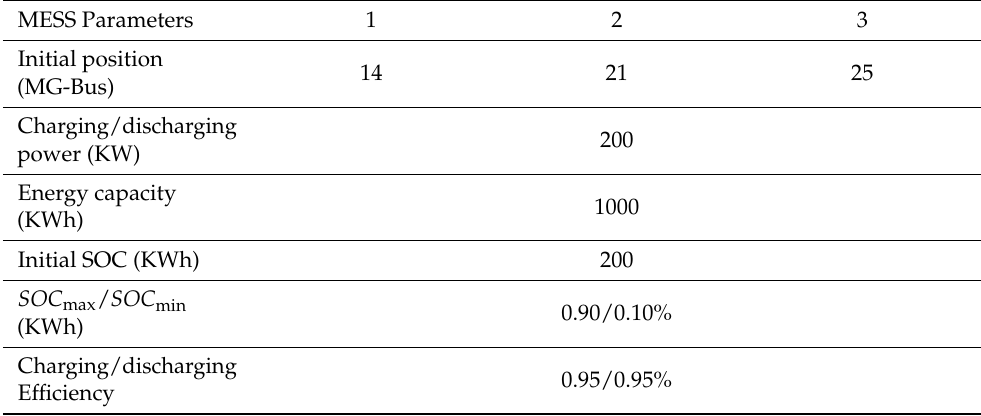
Table 3. MESSs Parameters.